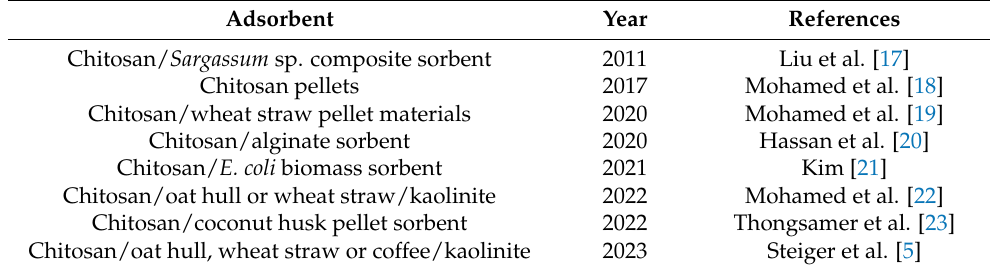
Table 1. Summary of various chitosan/biomass pellet-typed sorbent materials for fuel and/or water